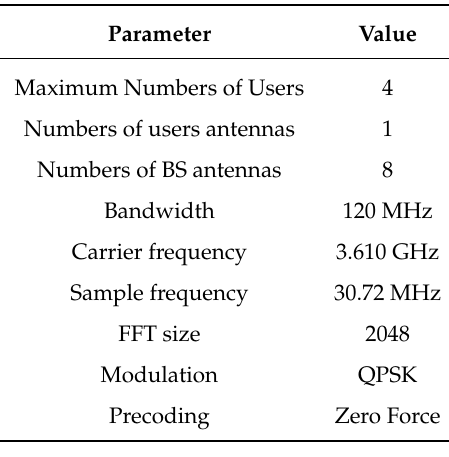
Table 3. Signal Parameter.